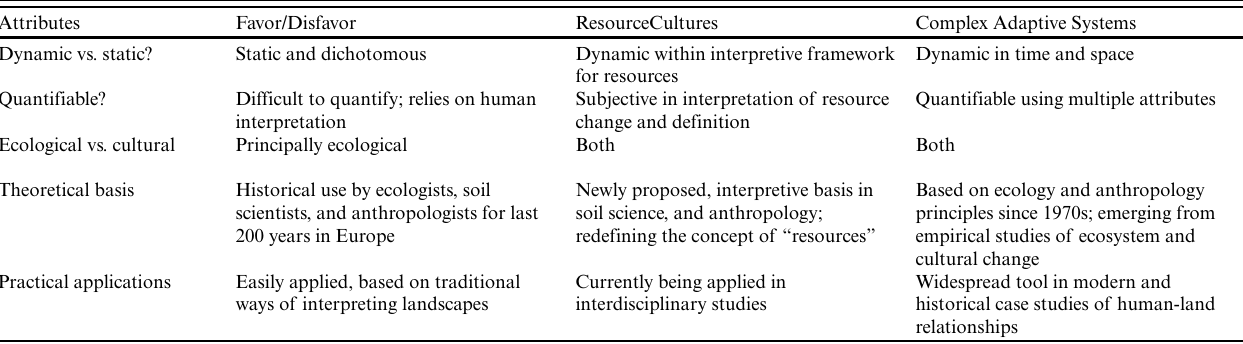
Table 1 . Three systems for evaluating landscape change and human